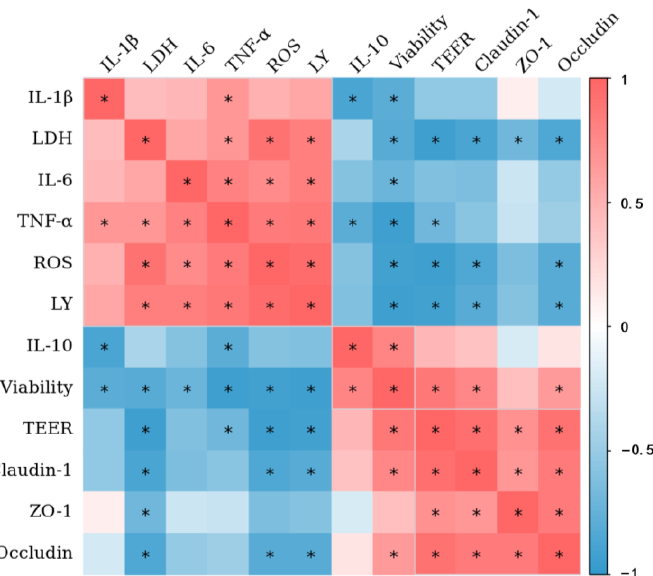
Figure 9. The heat map shows a correlation between cell viability, LDH release, TEER, the paracellular flux of LY, ROS production, inflammatory cytokines, and TJ proteins of Caco-2 cells. The heat map represents a visual indication of the correlation values among each pair of parameters represented in the respective rows and columns of the matrix. (*) p < 0.05.